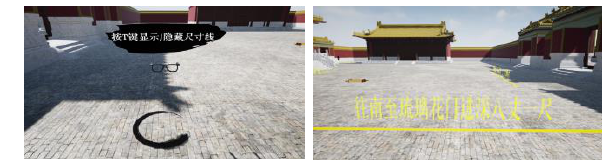
Figure 14. Glasses and Text prompt Figure 15. The information that extracted from Yangshi Lei